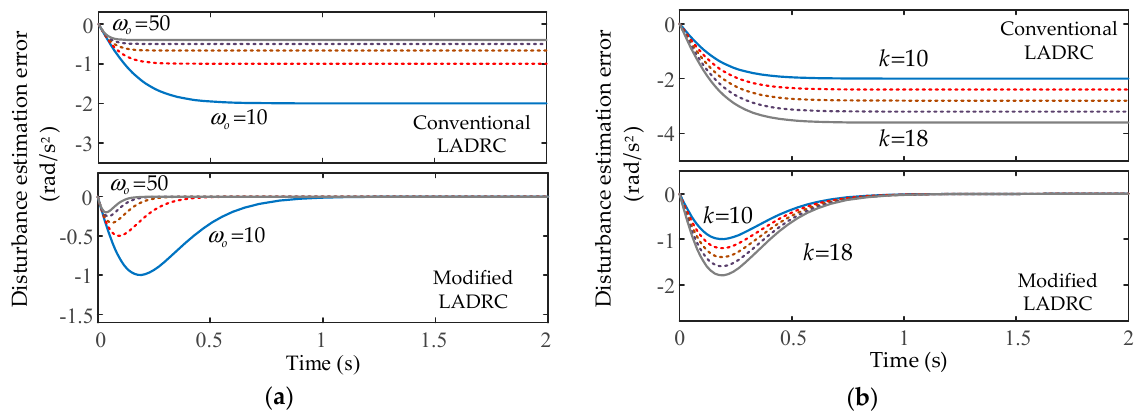
Figure 7. Estimation error of slope disturbance between conventional LADRC and modified LADRC: ( a ) Different observer bandwidth ω o ; ( b ) Different slope k .